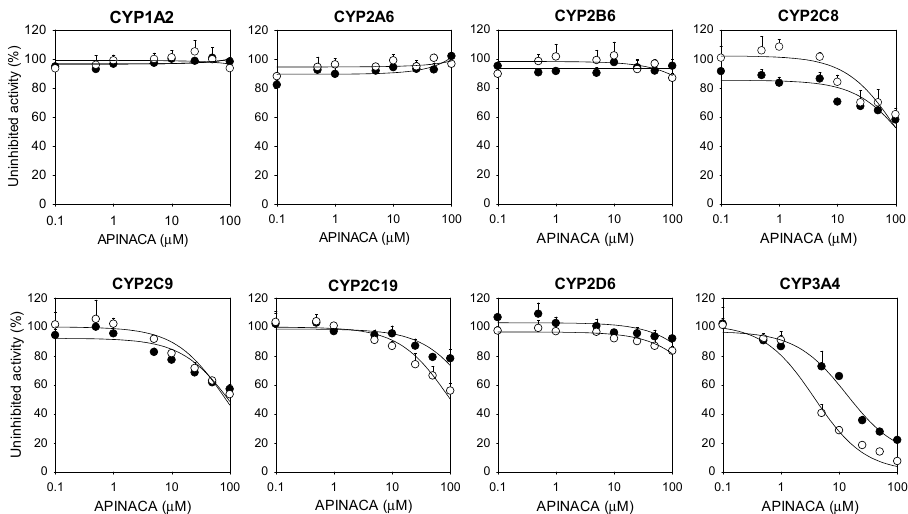
Figure 2. Inhibitory effect of APINACA on CYP1A2-mediated phenacetin O -deethylase, CYP2A6-mediated coumarin 7-hydroxylase, CYP2B6-mediated bupropion hydroxylase, CYP2C8-catalyzed amodiaquine N -deethylase, CYP2C9-catalyzed diclofenac 4 ′ -hydroxylase, CYP2C19-mediated [ S ]- mephenytoin 4 ′ -hydroxylase, CYP2D6-mediated bufuralol 1 ′ -hydroxylase, and CYP3A4-mediated midazolam 1 ′ -hydroxylase activities in ultrapooled human liver microsomes with ( ) and without